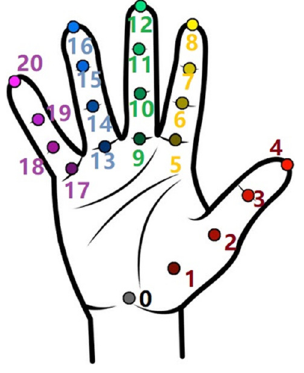
Figure 3. YuMi imitating movement in RobotStudio simulation.